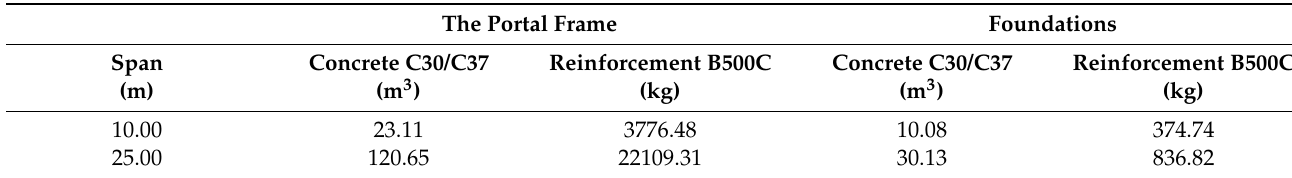
Table 4. Quantities of the reinforced concrete frames.